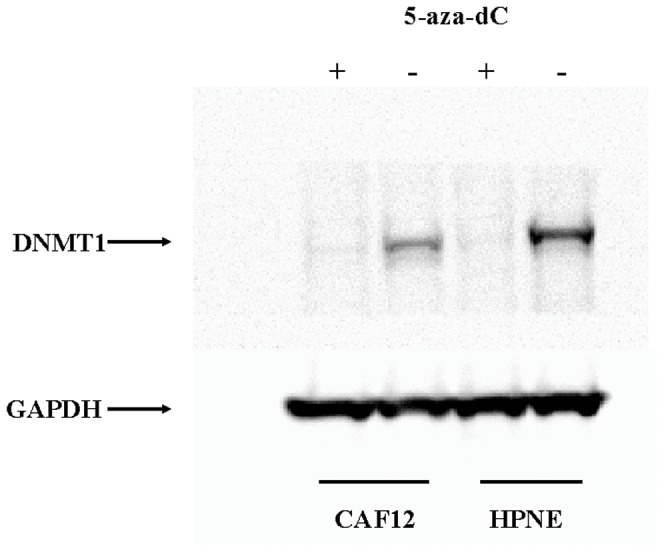
Effect of 5-aza-dC treatment on DNMT1 protein levels by Western blot analysis of pancreatic CAF and control fibroblast cultures.DNMT1 protein is depleted (relative to GAPDH) in 5-aza-dC treated HPNE and CAF12 cells.